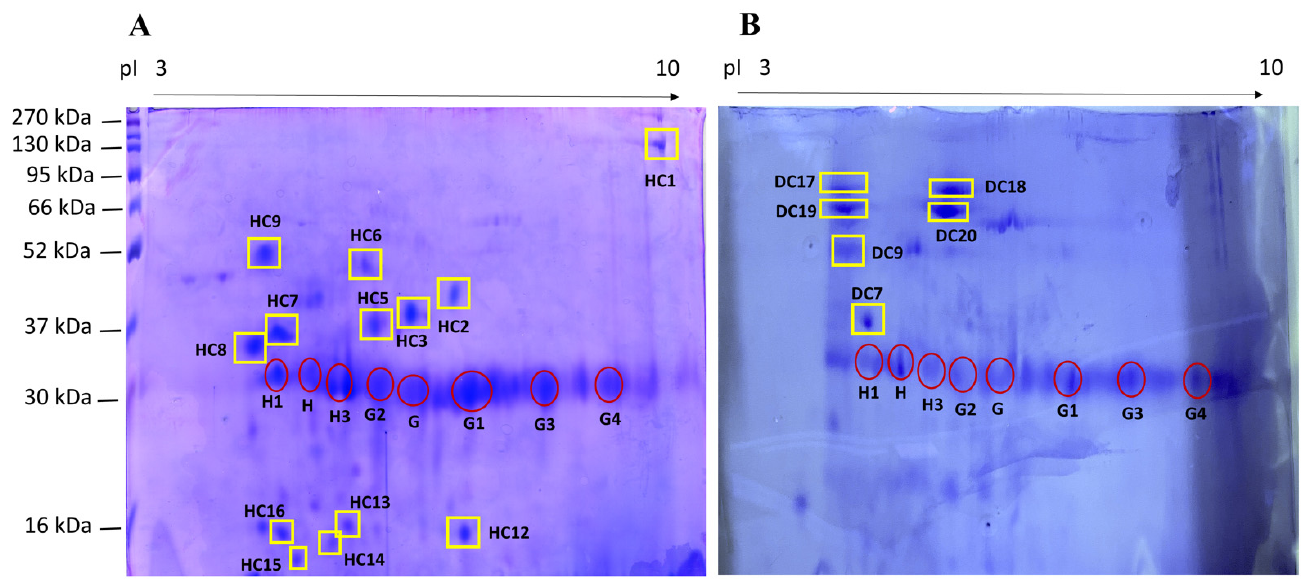
Figure 1. 2DE proteomic map of feces from ( A ) healthy cheetahs (HC); ( B ) diseased cheetahs (DC). The proteins were separated on an immobilized pH 3–10 linear gradient strip and subsequently subjected to 13% SDS-PAGE. The standards were: Prestained Protein Sharpmass VII, range 6.5–270 kDa (Euroclone). Highlighted with a yellow square are the spots identified in this work by mass spectrometry. The spots identified by comparing the gels obtained from HC and DC with those already present in the literature [7–9] are highlighted with red circles.